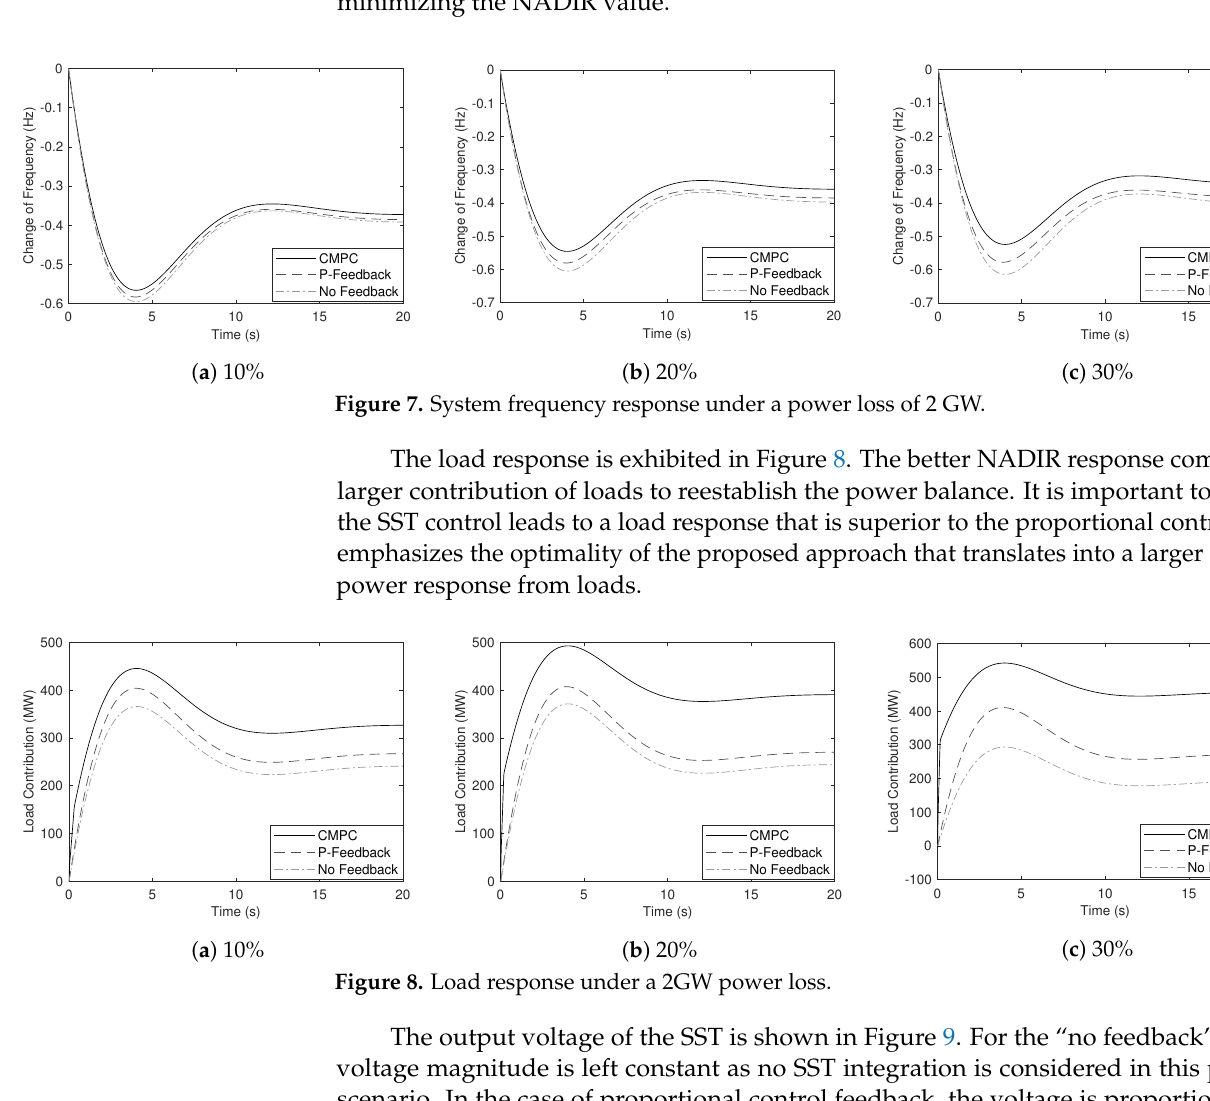
30% of SST penetration. This result is consistent with the objective of the control action in minimizing the NADIR value.